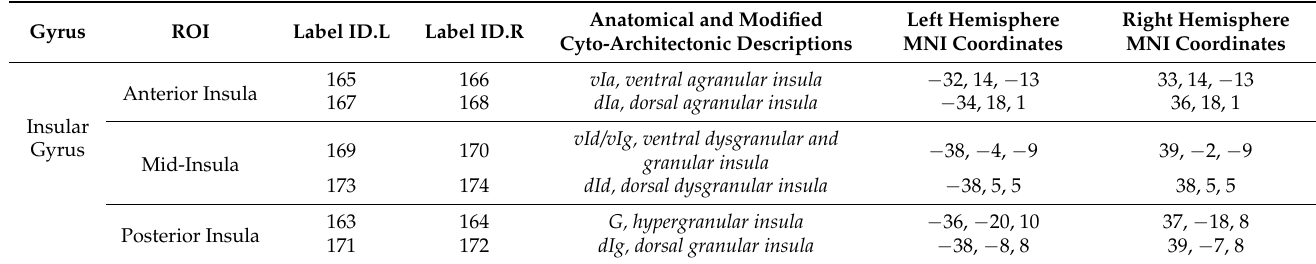
Table A2. Peak coordinates of the clusters from group fMRI analysis for the mean Focus-on-Breath vs. Describe contrast. Insular regions defined by the Brainnetome atlas